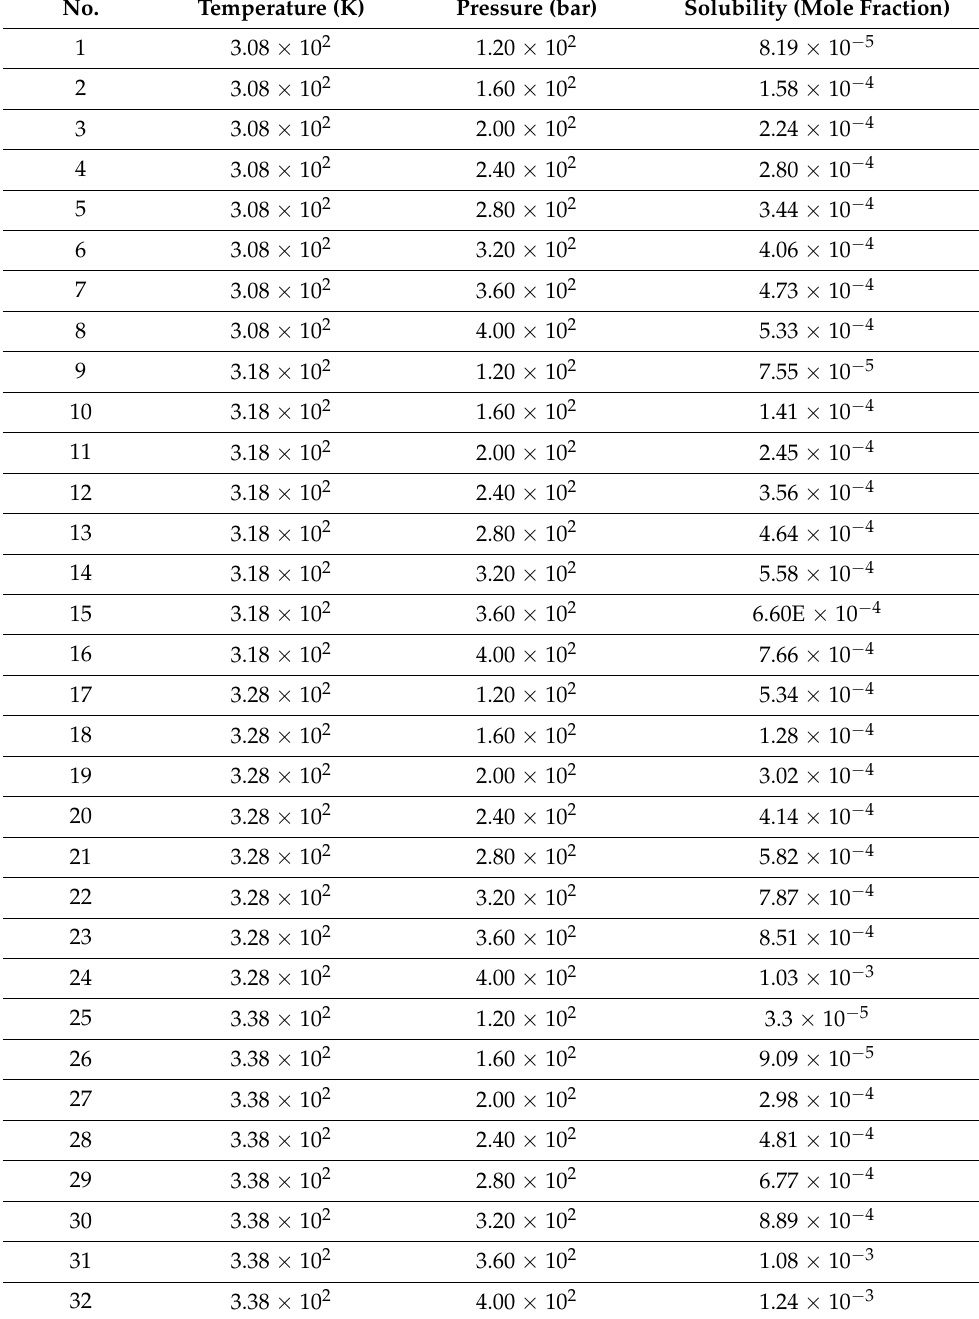
Table 1. The dataset based on input and